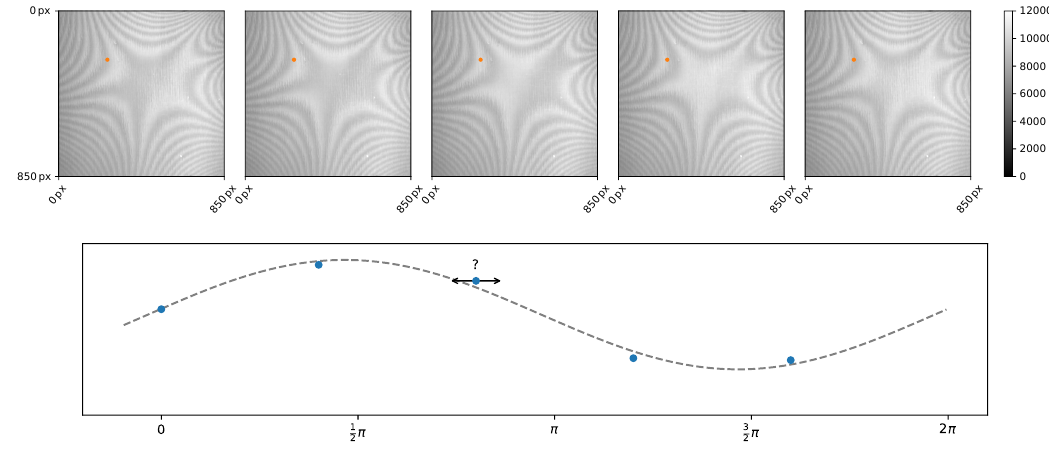
Figure 1. Example for a grating interferometric phase stepping series (without sample, cf. Section 2.3 for experimental details). The intensity variation throughout the series is visually most perceivable in the center. The Moiré fringes are caused by imperfectly matched gratings and will translate to reference offset phases of the sinusoid curves found at each detector pixel (cf. Figure 2). The bottom panel shows a corresponding phase stepping curve for the pixel marked orange in the above image series. The sampling positions are subject to an unknown error.